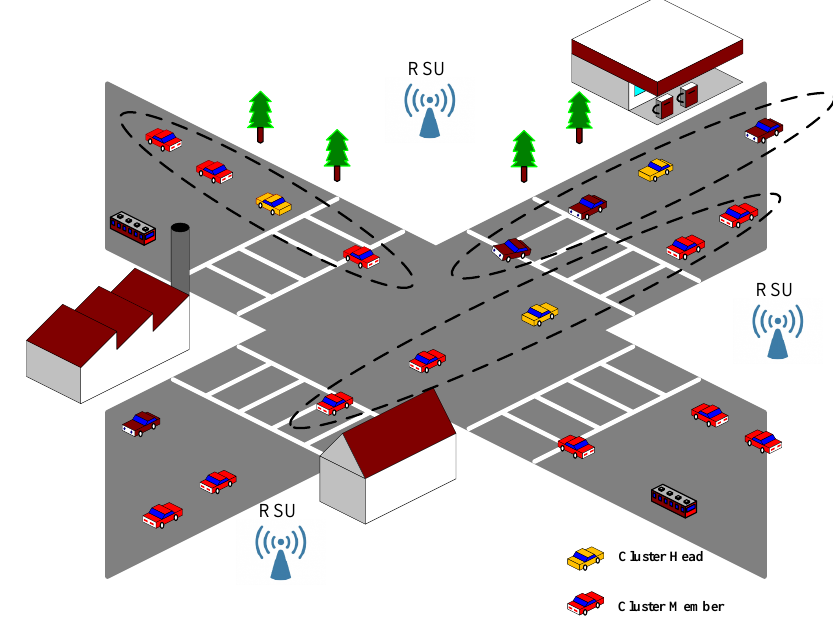
Figure 1. System